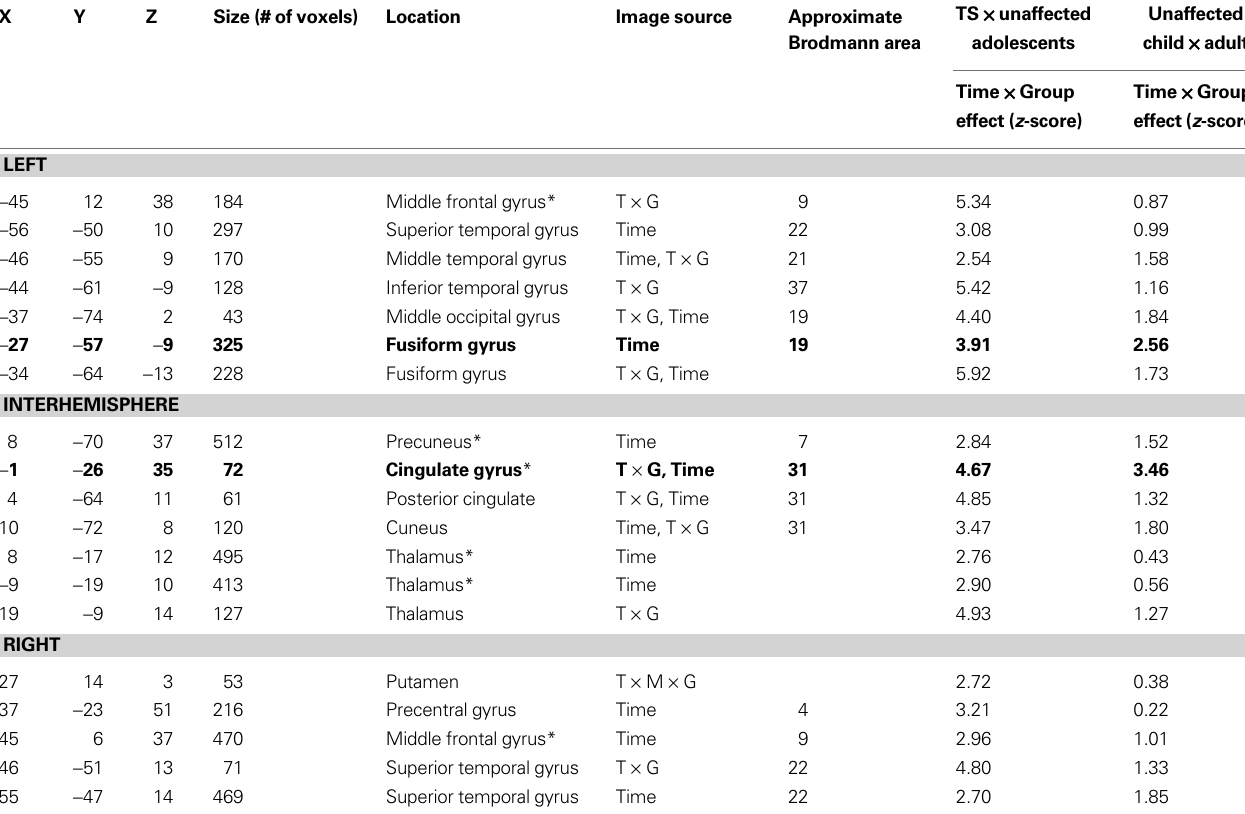
Table 3 | START-CUES: 19 brain regions showing a signifi cant effect in the direct comparison (unaffected vs TS adolescent groups) of time × group; all have signifi cantly smaller activity in the TS group (sphericity-corrected p -values <